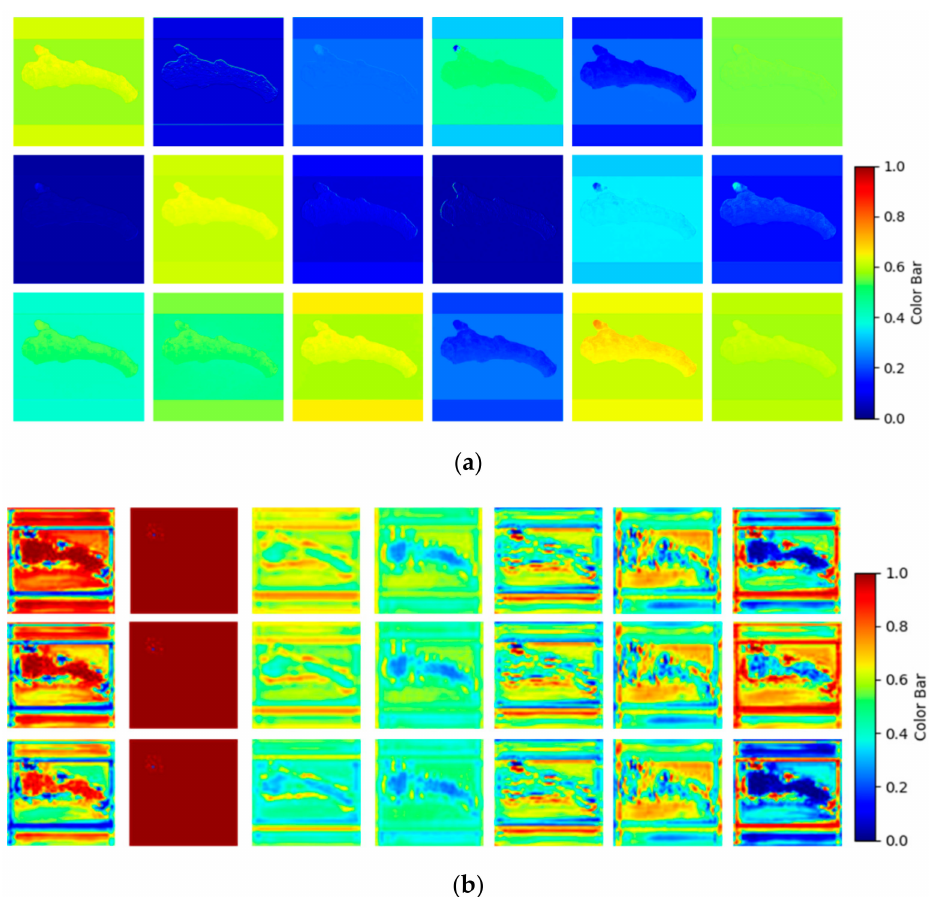
Figure 11. Visualization of convolutional neural networks. ( a ) feature map of the first convolution layer, ( b ) feature map of the final YOLO